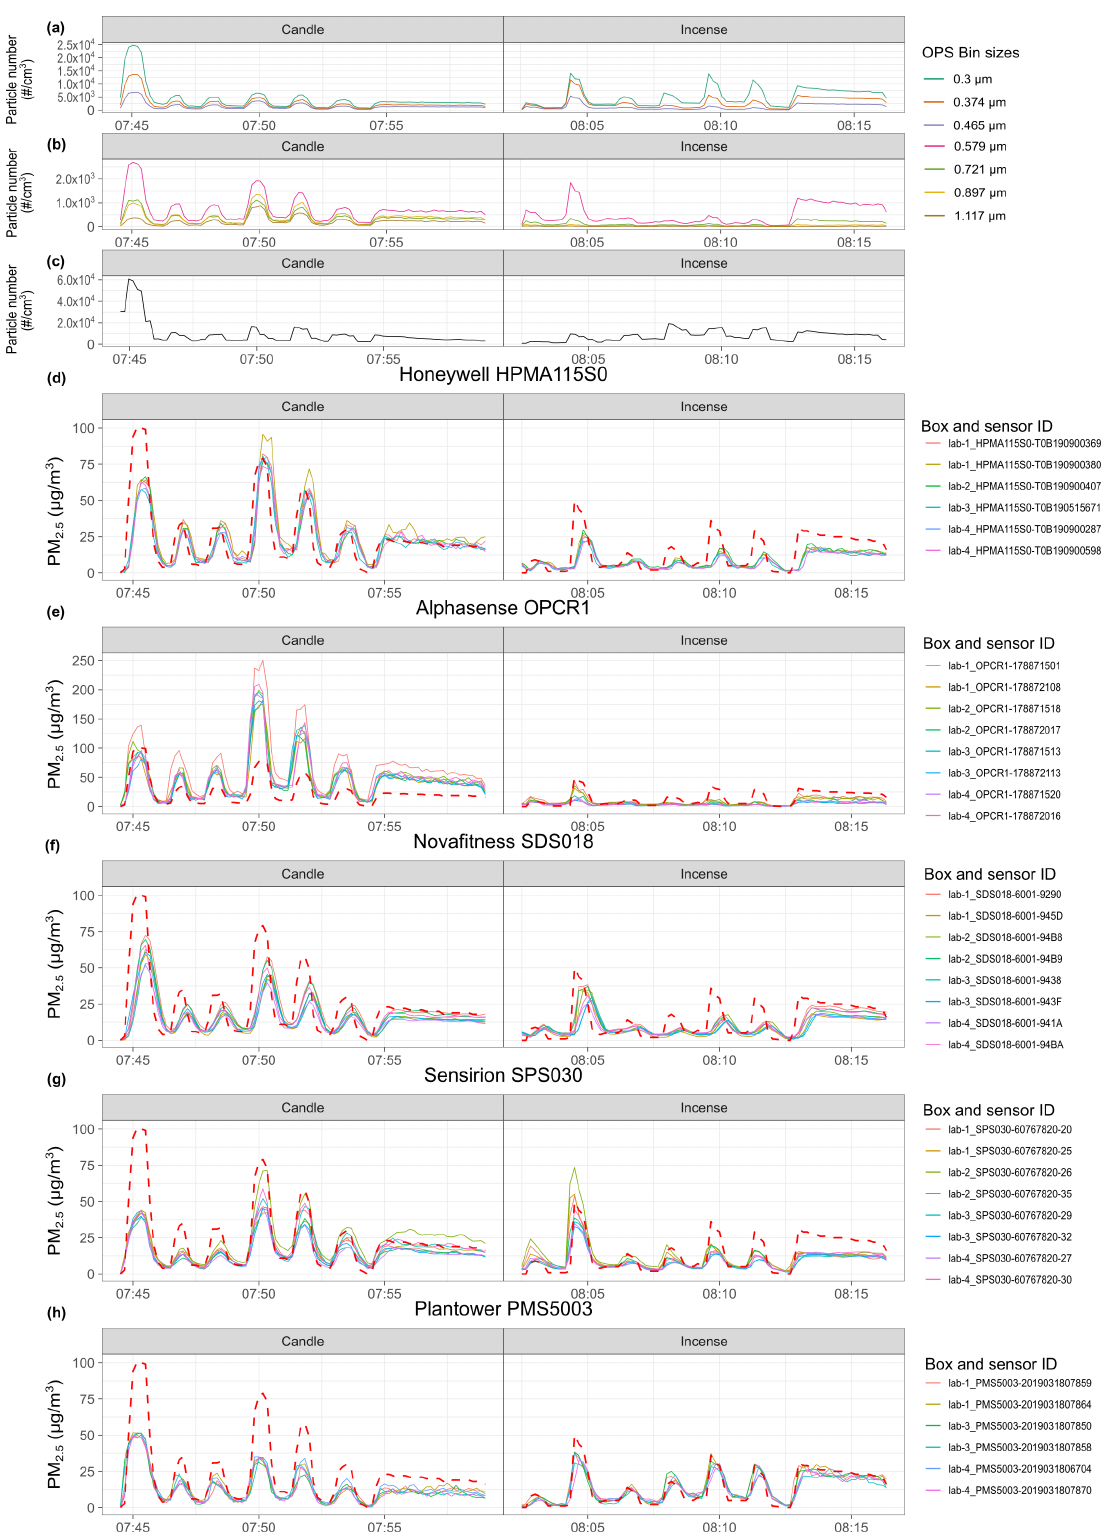
Figure 4. Time series of experiment 1. From top to bottom: ( a , b ) TSI 3330 OPS Bin size distribution; ( c ) Nanotracer ultrafine particles number concentration /mL; ( d – h ) PM 2.5 of the sensors for each model of sensor, against DustTrak (red dotted line). The sensors are named according to the box they are placed in and their serial